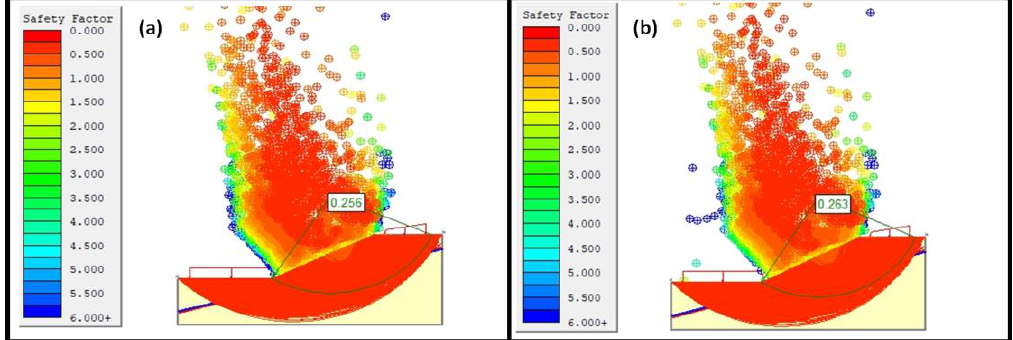
Figure 13. Safety factor simulated for rainy conditions in clay soil slope using ( a ) Corp of Engineers’ Number Two method and ( b ) the Lower Karafiath method.